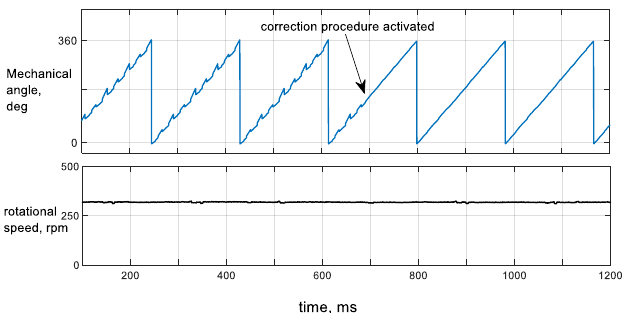
Figure 10. The course of the estimated Θ M angle and the measured rotational speed with the moment of starting the proposed estimation procedure marked.